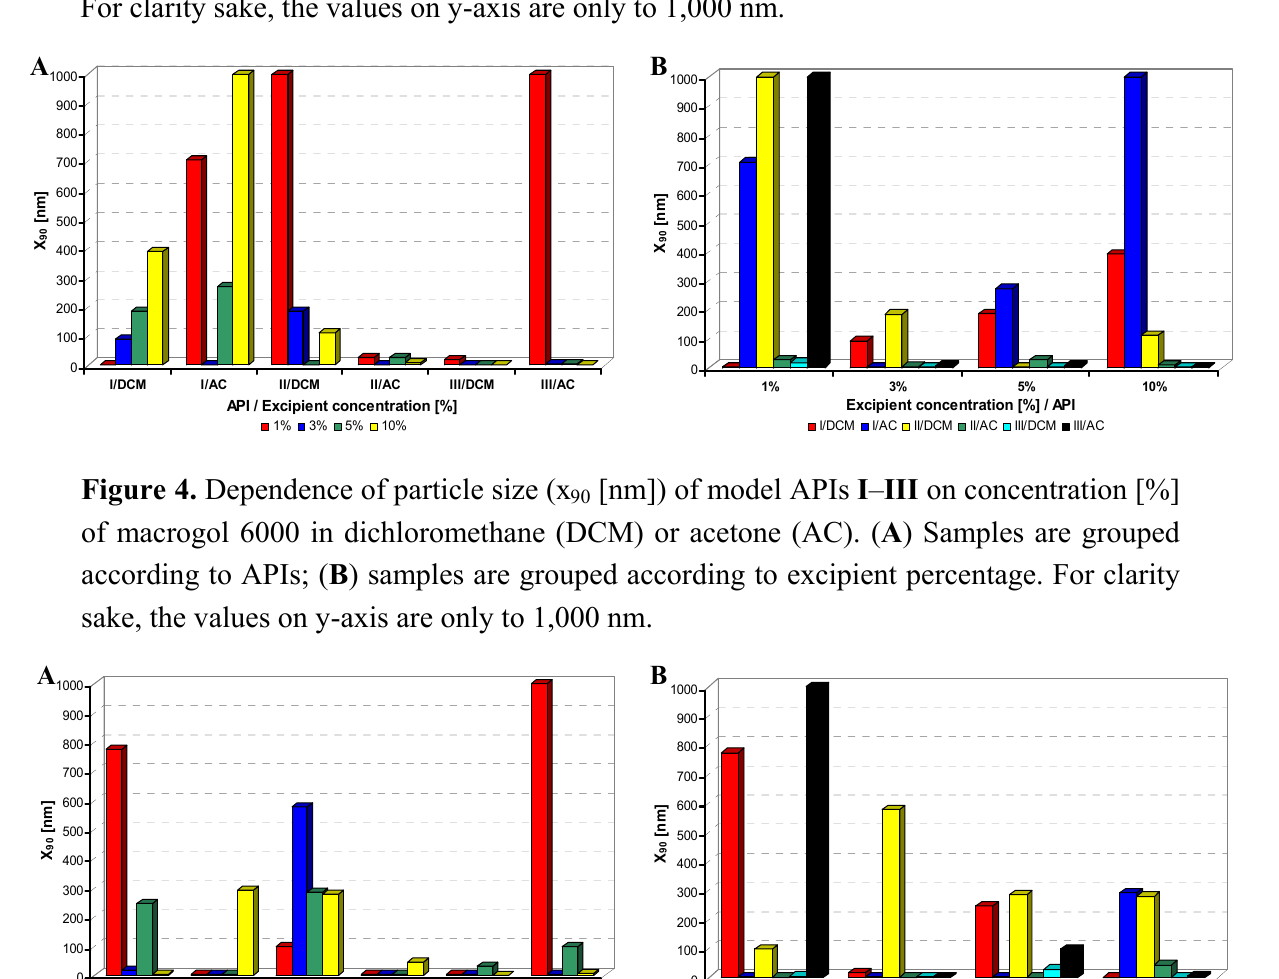
Figure 3. Dependence of particle size (x [nm]) of model APIs I – III on concentration [%] 90 of sodium dodecyl sulfate in dichloromethane (DCM) or acetone (AC). ( A ) Samples are grouped according to APIs; ( B ) samples are grouped according to excipient percentage. For clarity sake, the values on y-axis are only to 1,000 nm.